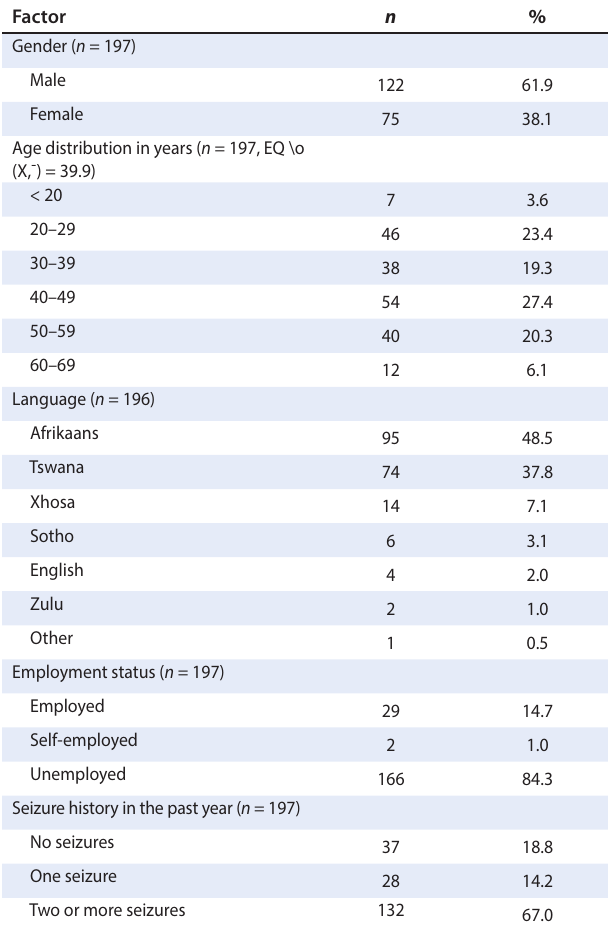
Table 1: Demographic characteristics of participants presenting with epilepsy at the Kimberley Hospital Complex and clinics